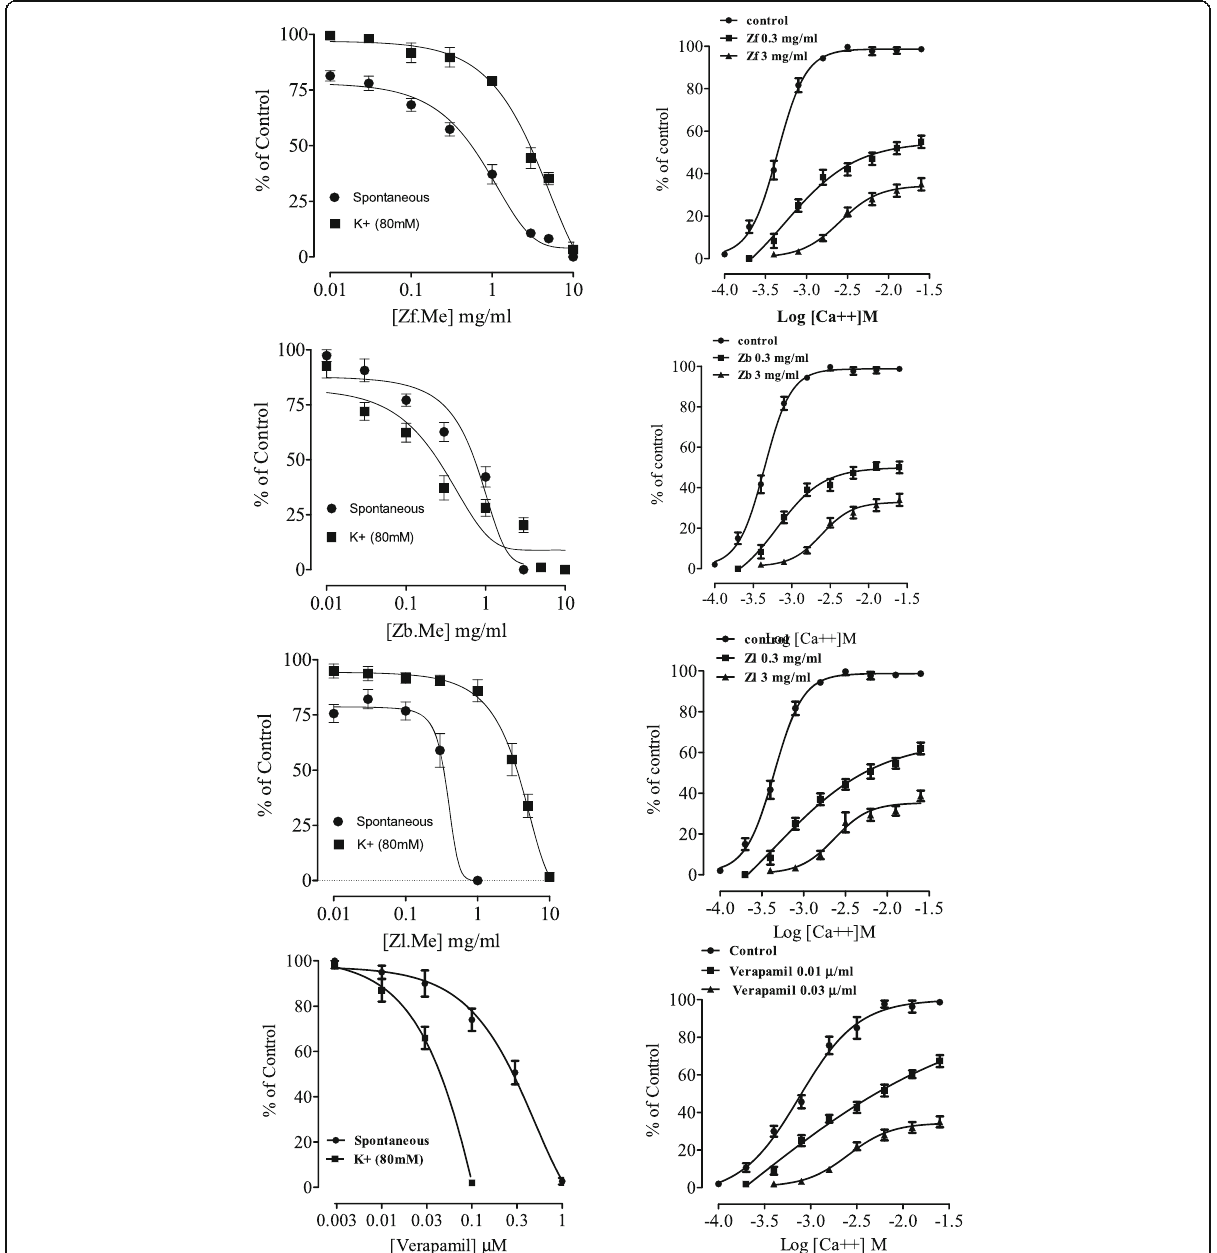
Fig. 1 The effect of Z. armatum ; crude extract of fruit (Zf), bark (Zb), and leaves (Zl) on spontaneous and high K + [80 mM] induced contractions in isolated rabbit jejunum preparation along with Ca ++ concentration response curves in the absence and presence of different concentrations of extracts and verapamil respectively. (All values are expresses as the mean ± SEM; n = 5 –